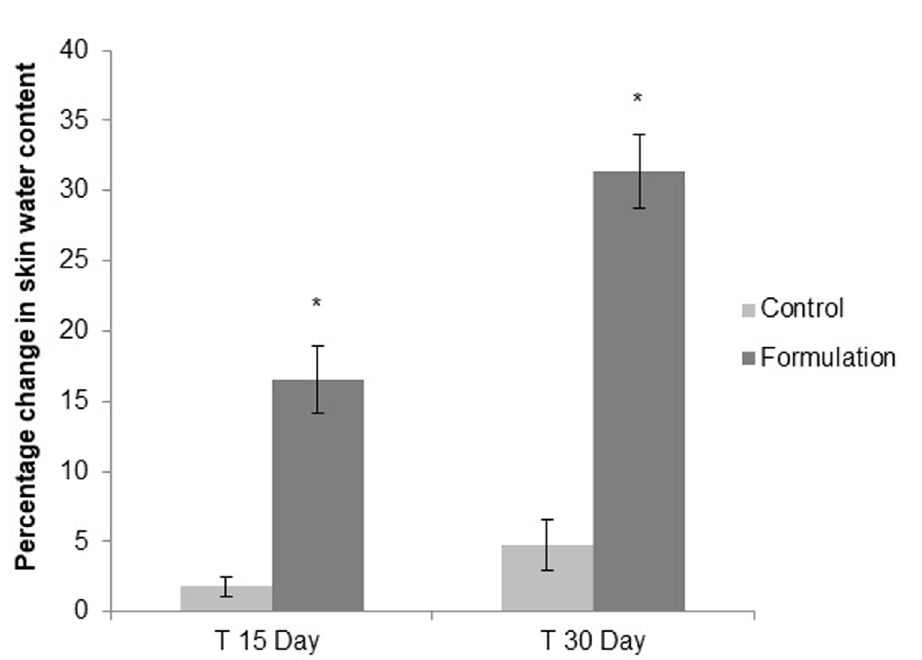
FIGURE 3 - Percentage increase in skin water content for the control (hydrogel without the Gac extract) and the formulation containing the Gac extract after the 15- and 30-day application period compared to the values before treatment (mean ± SD). * Significantly different from day zero of each treatment ( p ≤ 0.05).